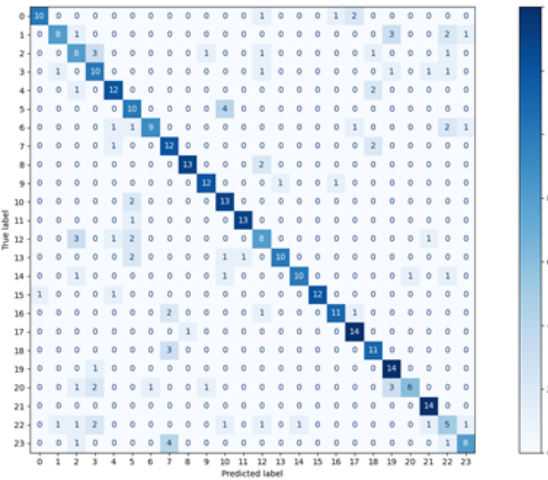
Figure 5. Confusion Matrix—Random